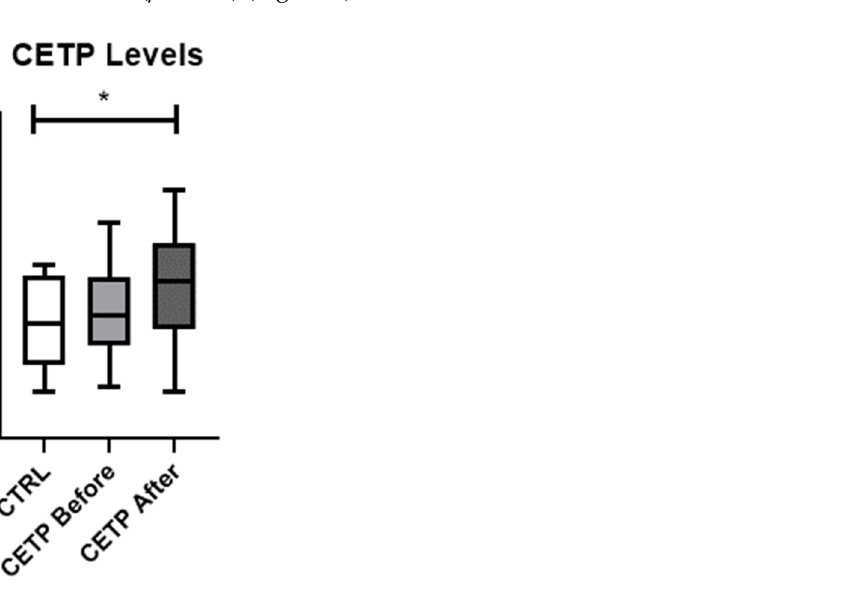
Figure 1. Concentrations of CETP in patients (before and after the treatment) and controls. * means p < 0.05 when comparing all three groups using ANOVA-test.